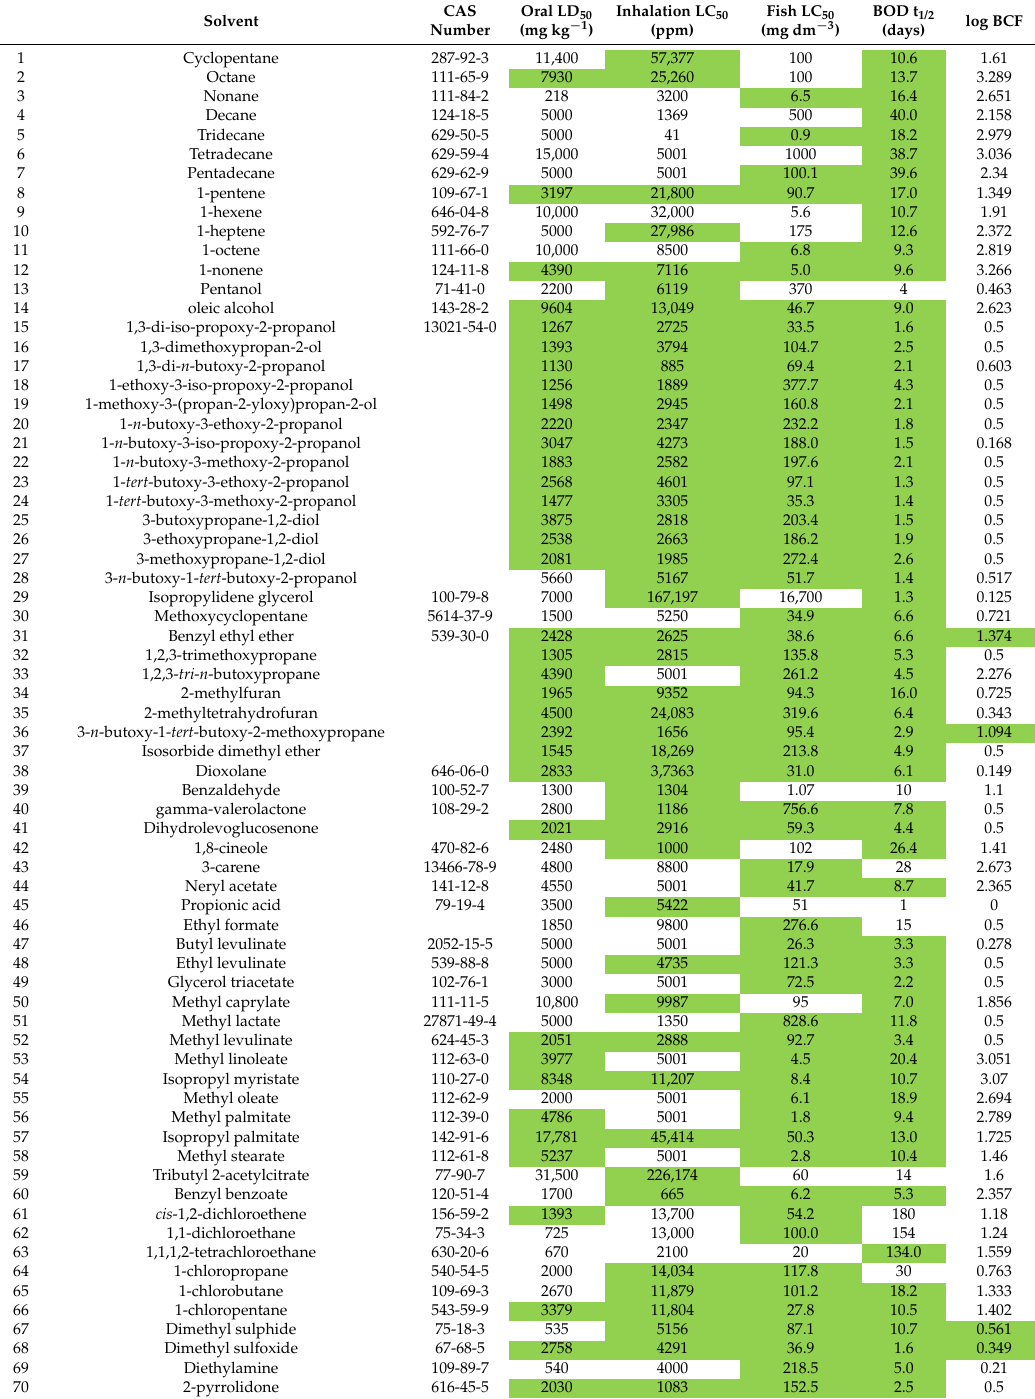
Table 3. Input and completed values (shaded) for solvents that were not fully characterized. Green color indicate predicted